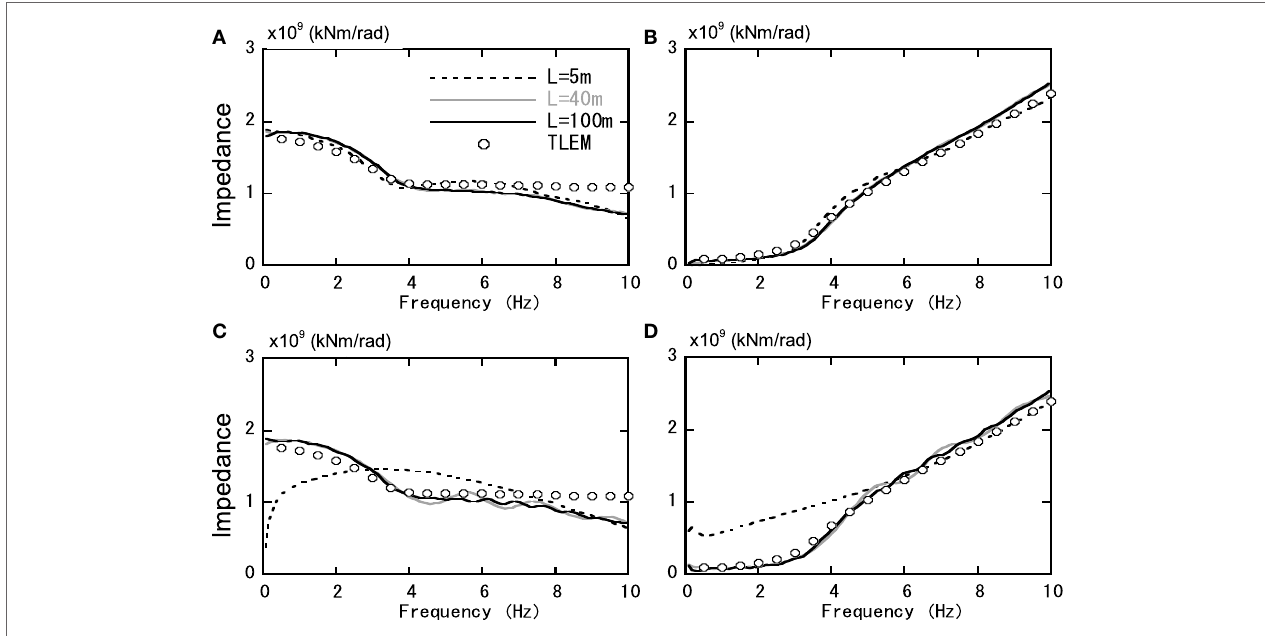
FigUre 10 | comparison of soil impedance (rotational) . (a) 3D-TB (real). (B) 3D-TB (imag.). (c) VB (real). (D) VB